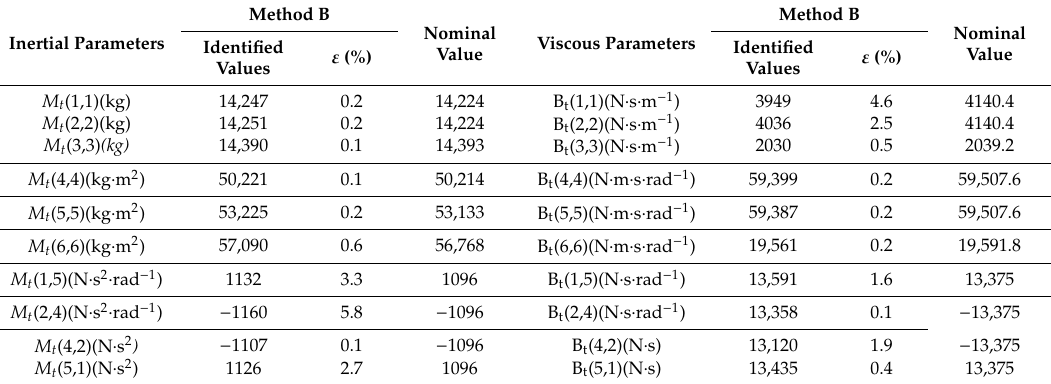
Table 6. Identification results of parameters of the Simulink model with 30 N of Coulomb friction. Method Inertial Parameters